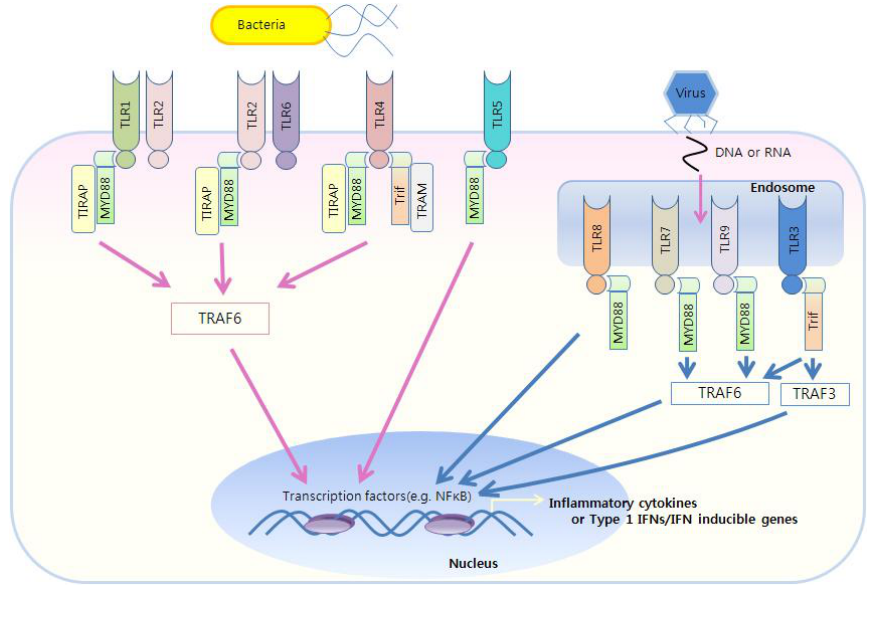
Figure 4. TLR-mediated immune responses. TLR1/2 and TLR2/6 utilize MyD88 and TIRAP as essential adaptors. TLR3 utilizes Trif. TLR4 utilizes four adaptors, including MyD88, TIRAP, Trif, and TRAM. TLR7/8, TLR9 and TLR5 use only MyD88. The MyD88-dependent pathway controls inflammatory responses, while Trif mainly mediates type I IFN